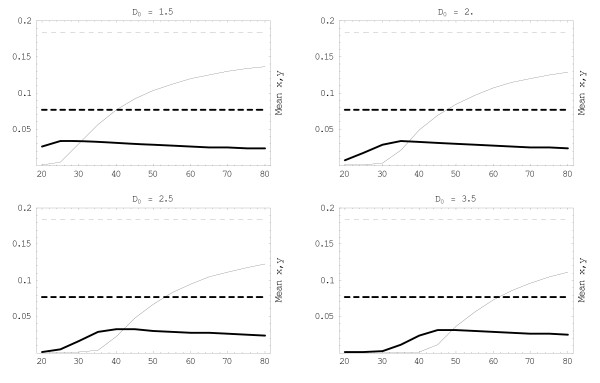
Time average densities. Periodically treated mean values x¯
 MathType@MTEF@5@5@+=feaafiart1ev1aaatCvAUfKttLearuWrP9MDH5MBPbIqV92AaeXatLxBI9gBaebbnrfifHhDYfgasaacH8akY=wiFfYdH8Gipec8Eeeu0xXdbba9frFj0=OqFfea0dXdd9vqai=hGuQ8kuc9pgc9s8qqaq=dirpe0xb9q8qiLsFr0=vr0=vr0dc8meaabaqaciaacaGaaeqabaqabeGadaaakeaacuWG4baEgaqeaaaa@2E3D@, y¯
 MathType@MTEF@5@5@+=feaafiart1ev1aaatCvAUfKttLearuWrP9MDH5MBPbIqV92AaeXatLxBI9gBaebbnrfifHhDYfgasaacH8akY=wiFfYdH8Gipec8Eeeu0xXdbba9frFj0=OqFfea0dXdd9vqai=hGuQ8kuc9pgc9s8qqaq=dirpe0xb9q8qiLsFr0=vr0=vr0dc8meaabaqaciaacaGaaeqabaqabeGadaaakeaacuWG5bqEgaqeaaaa@2E3F@ (thick/thin) as functions of period 35 <T < 120 for increased initial dose 1.5 <DY < 3.5. Increased DY and frequency 1/T facilitate the onset of drug-resistance (dominant x¯
 MathType@MTEF@5@5@+=feaafiart1ev1aaatCvAUfKttLearuWrP9MDH5MBPbIqV92AaeXatLxBI9gBaebbnrfifHhDYfgasaacH8akY=wiFfYdH8Gipec8Eeeu0xXdbba9frFj0=OqFfea0dXdd9vqai=hGuQ8kuc9pgc9s8qqaq=dirpe0xb9q8qiLsFr0=vr0=vr0dc8meaabaqaciaacaGaaeqabaqabeGadaaakeaacuWG4baEgaqeaaaa@2E3D@), e.g. the transition period TR = 30 for DY = 1.5, is shifted towards TR = 49 for DY = 3.5. Dashed lines indicate untreated equilibria for y (thin) and x (thick). The parameter α = 2.06 > α1 assures 'y-domination' for the untreated case.